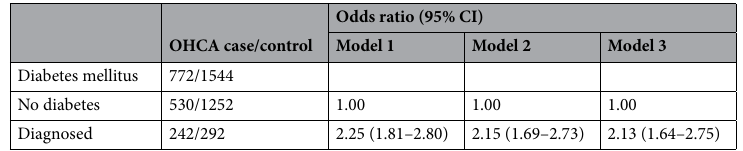
Table 2. Risk of diabetes mellitus for the out-of-hospital cardiac arrest among the study population. CI, confidence interval. Model 1: Unadjusted conditional logistic regression. Model 2: Conditional logistic regression adjusted for comorbidities (hypertension, myocardial infarction, stroke, dyslipidemia, and arrhythmia). Model 3: Conditional logistic regression adjusted for comorbidities (hypertension, myocardial infarction, stroke, dyslipidemia, and arrhythmia) and health behaviors (current smoking status, obesity, and regular exercise during the last year).